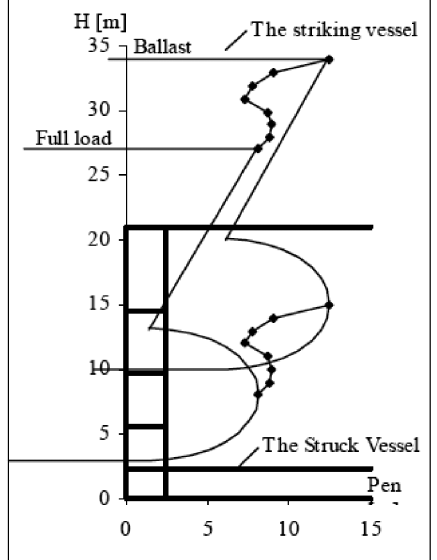
Fig. 5. Penetration of the striking vessel into a struck vessel